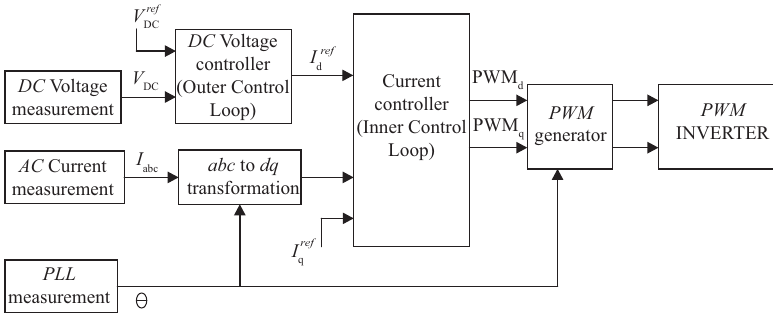
Figure 4. Vectorial control scheme.